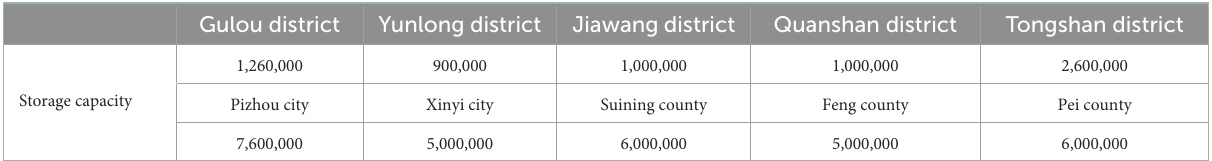
TABLE 6 Storage capacity of each